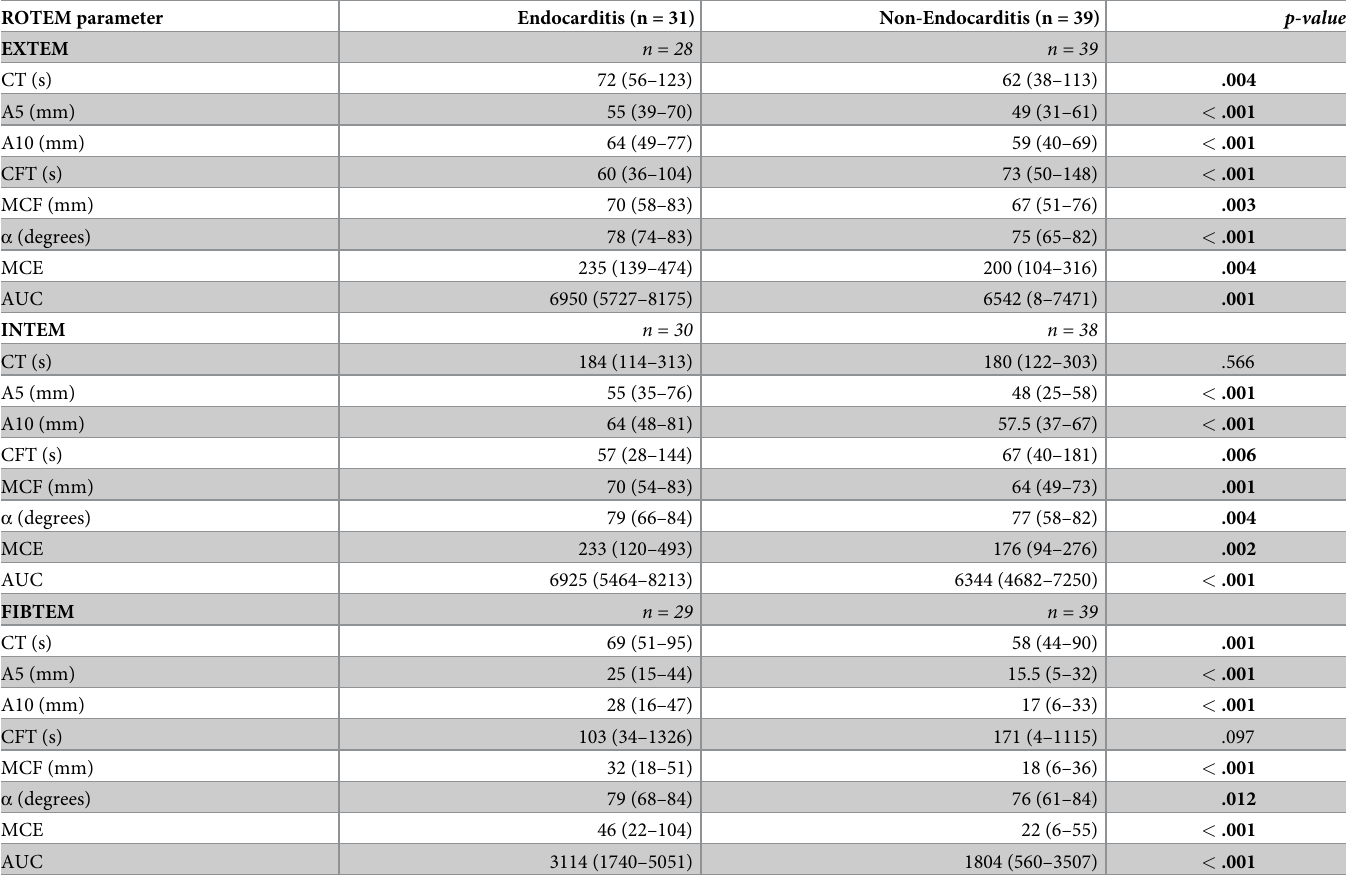
Table 3. Preoperative ROTEM parameters of patients with and without infective endocarditis.